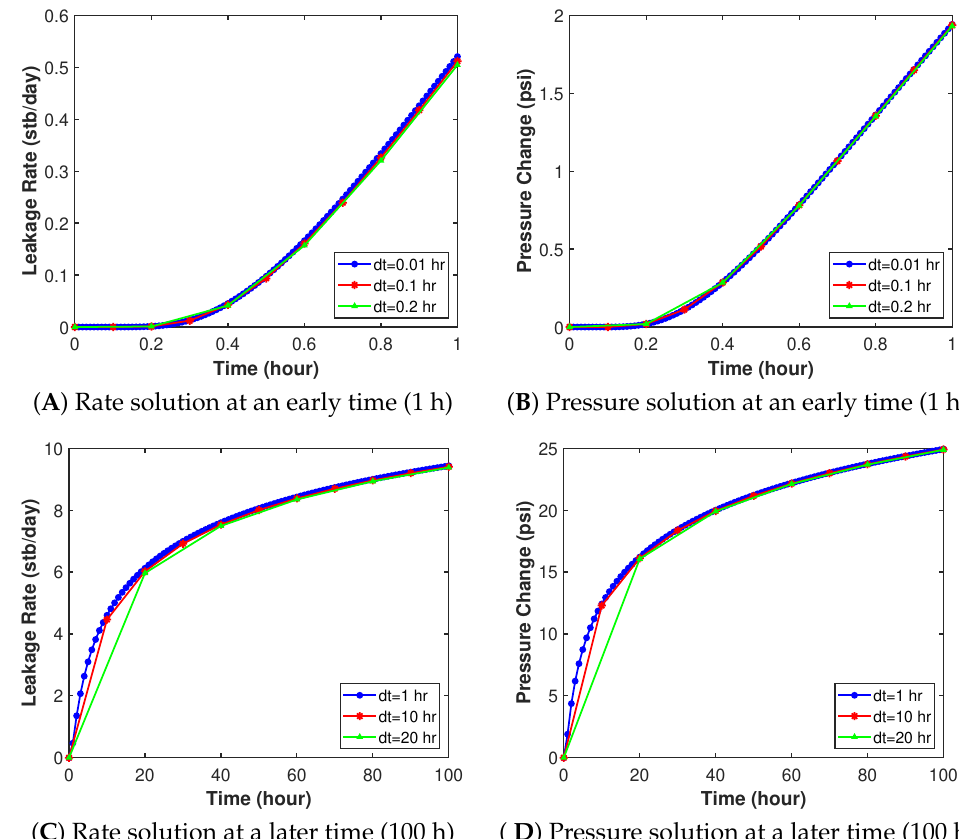
Figure 4. The leakage rate and pressure change solutions with different discretization intervals; dt = 0.01, 0.1, and 0.2 h ( A , B ), and dt = 1, 10, and 20 h ( C , D ) show that the ultimate solution is not impacted significantly by the discretization steps.